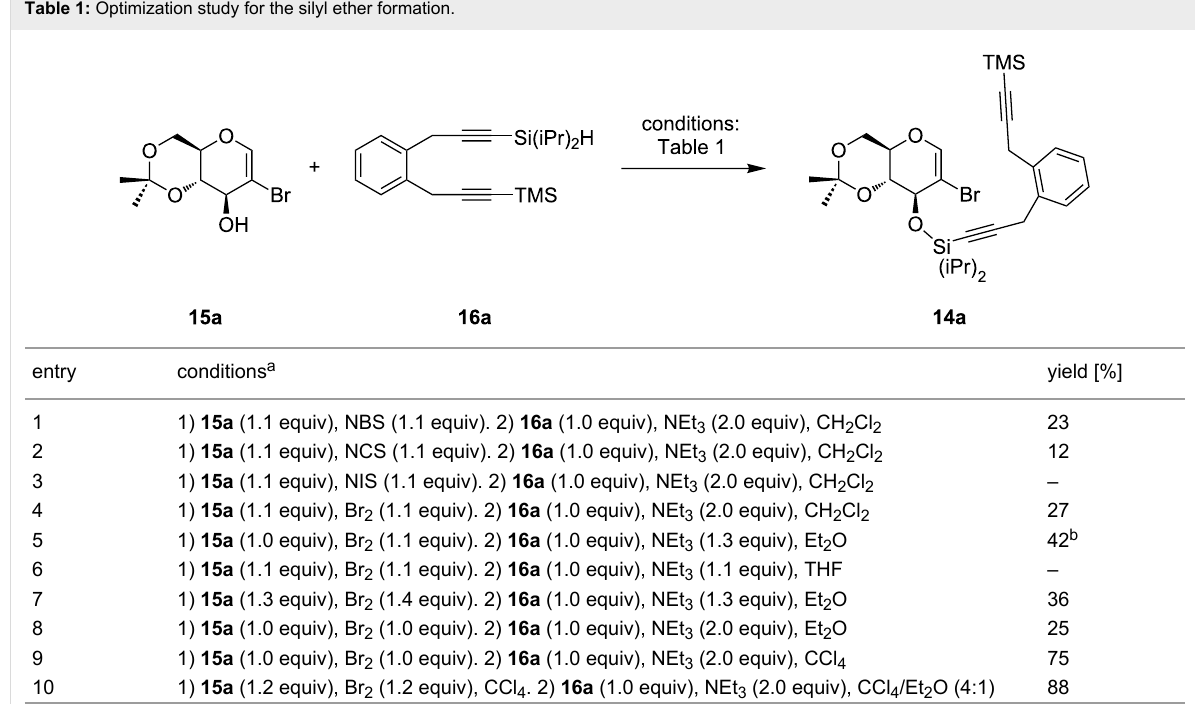
Table 1: Optimization study for the silyl ether